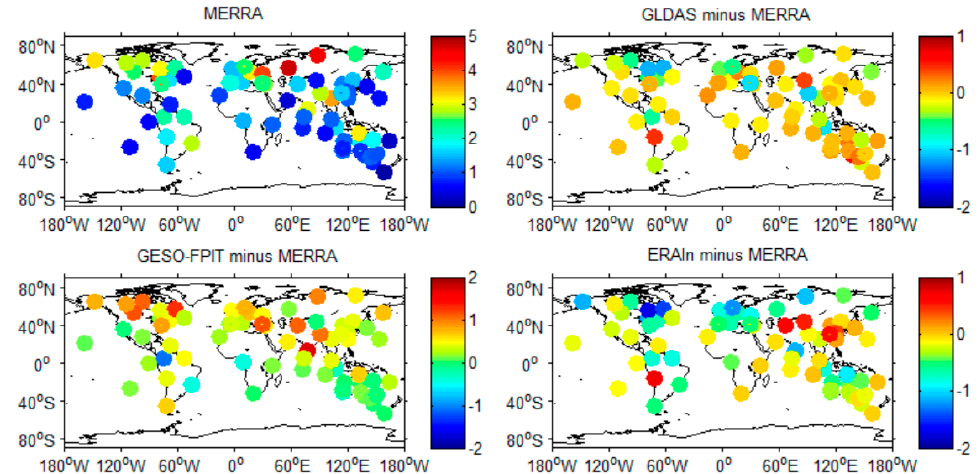
Figure 1. RMS of displacements (in units of mm) predicted by different hydrology models in the up component for 70 GPS stations from January 2001 to December 2014. MERRA was taken as a reference to distinguish the RMS differences of the four hydrology models more clearly.